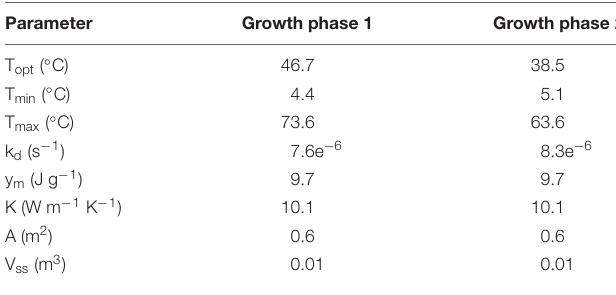
TABLE 3 | Calibrated parameters for two growth